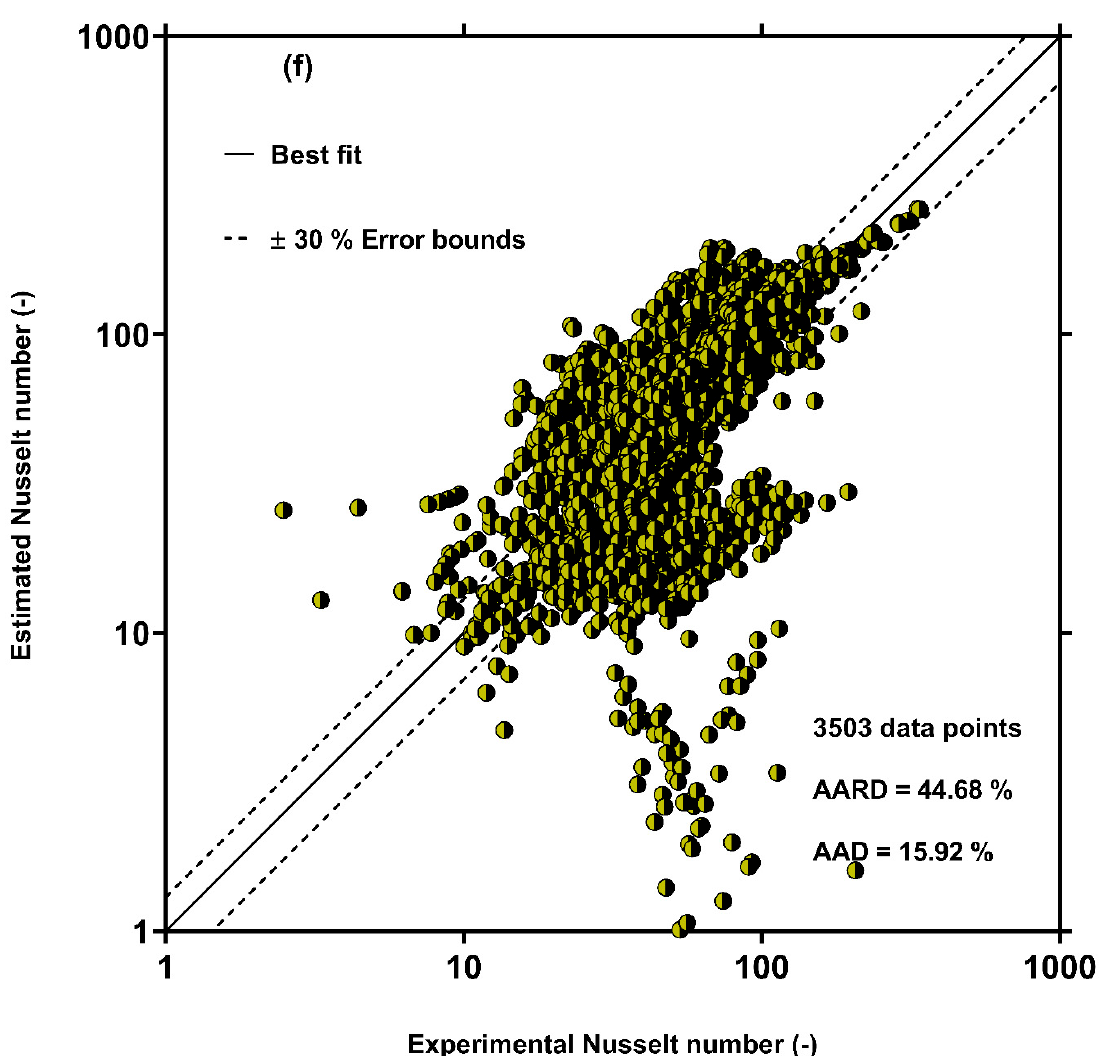
Figure 3. Comparison of predictions of the previous condensation HTC models with all 3503 experimental data points: ( a ) Kim and Mudawar [52], ( b ) Dorao and Fernandino [49], ( c ) Shah (2016) [90], ( d ) Shah (2019) [57], ( e ) Crosser [92] and ( f ) Hosseini et al. [56]. The solid points represent the outcomes of different models. The solid line represents the best fitting between experimental and estimated data, and the dash lines represent the ±30% error bounds.